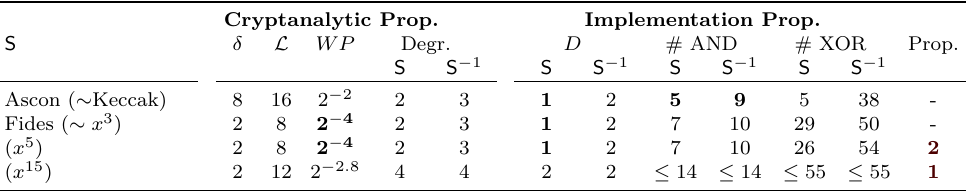
Table 4: Minimal-depth 5-bit S-boxes